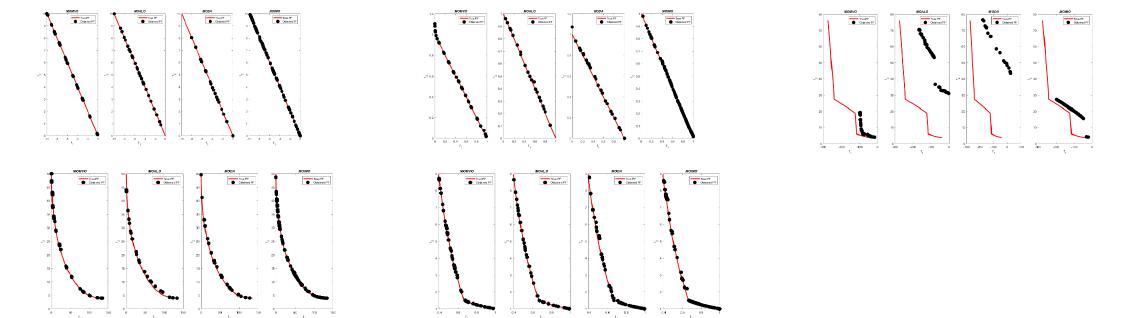
Fig. 3. Best pareto front for constrained benchmark